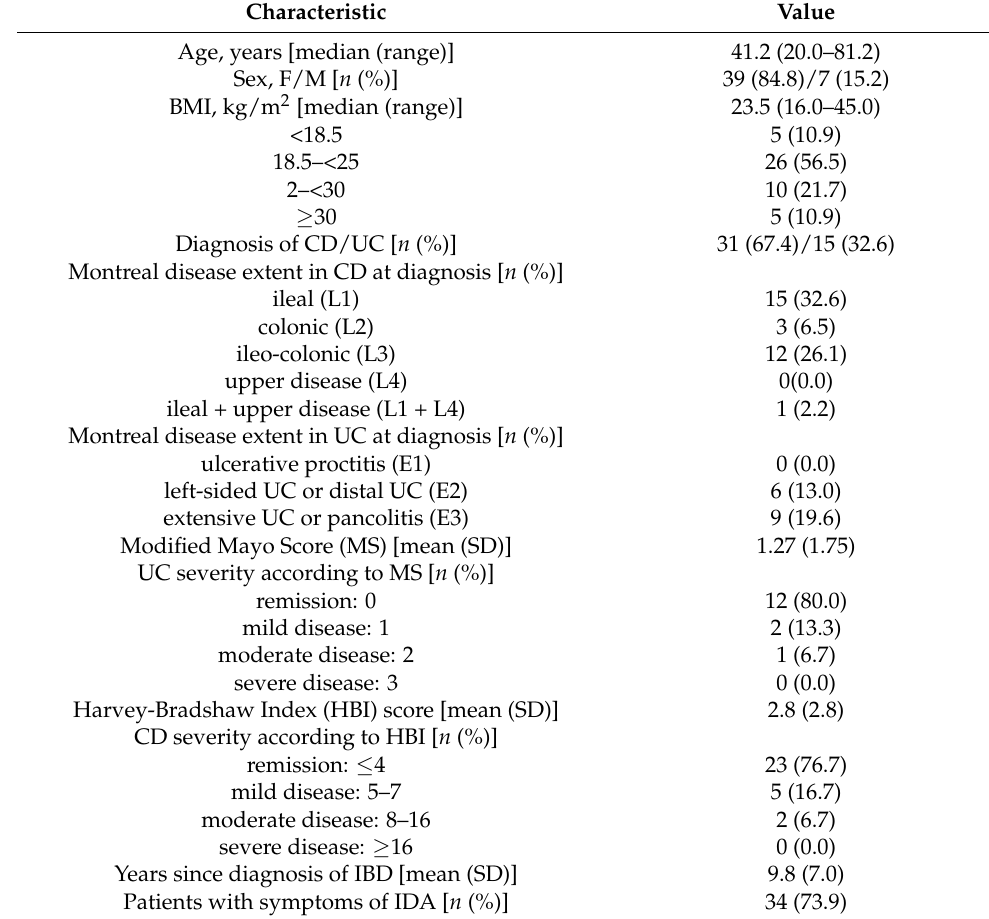
Table 1. Baseline characteristics of the intention-to-treat population ( n =